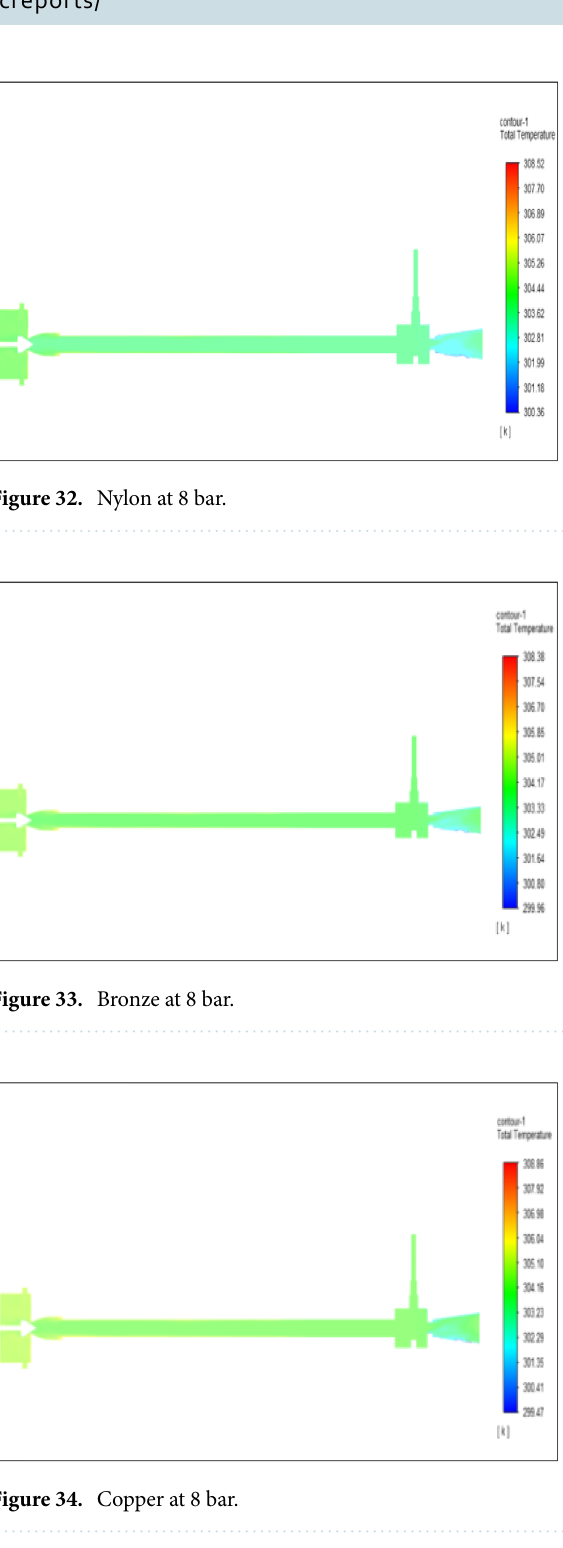
Figure37 represents to PVC vortex tube with an inlet pressure of 10 bars. The inlet temperature of the VT is 303 K. The hot air temperature was obtained at hot end as 308.70 K. Similarly, the cold end side obtained a value of 299.17 K. The maximum temperature difference was noticed as 9.53 K. Figure 38 represents to CPVC vortex tube with an inlet pressure of 10 bars. The inlet temperature of the VT is 303 K. The hot air temperature was obtained at the hot end as 308.77. Similarly, at cold end side obtained a value of 299.06 K. The maximum temperature difference was noticed as 9.72 K.